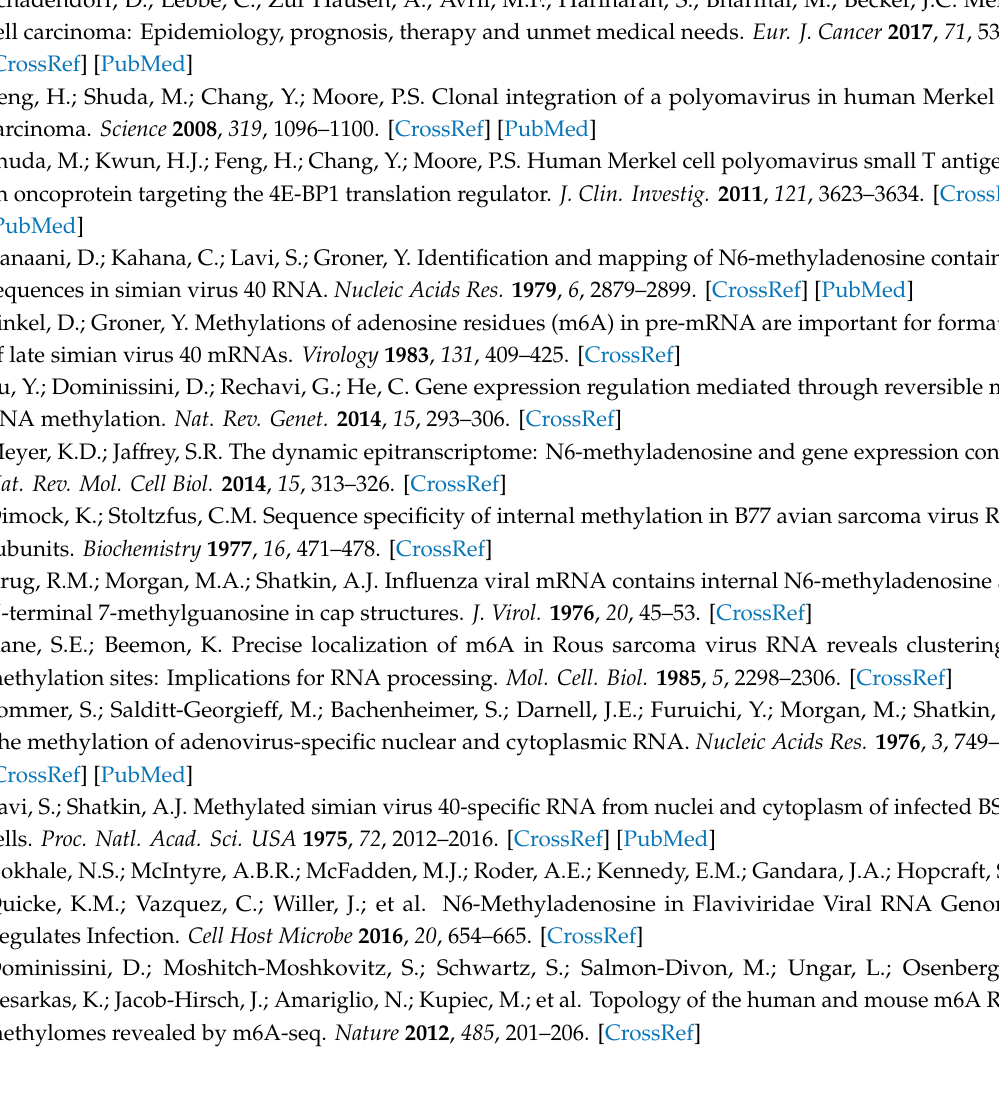
Figure S1: supplementary data corresponding to Figure 1, Figure S2: supplementary data corresponding to Figure 3, Figure S3: supplementary data corresponding to Figure 4, Figure S4. Whole blot for Figures 1 and